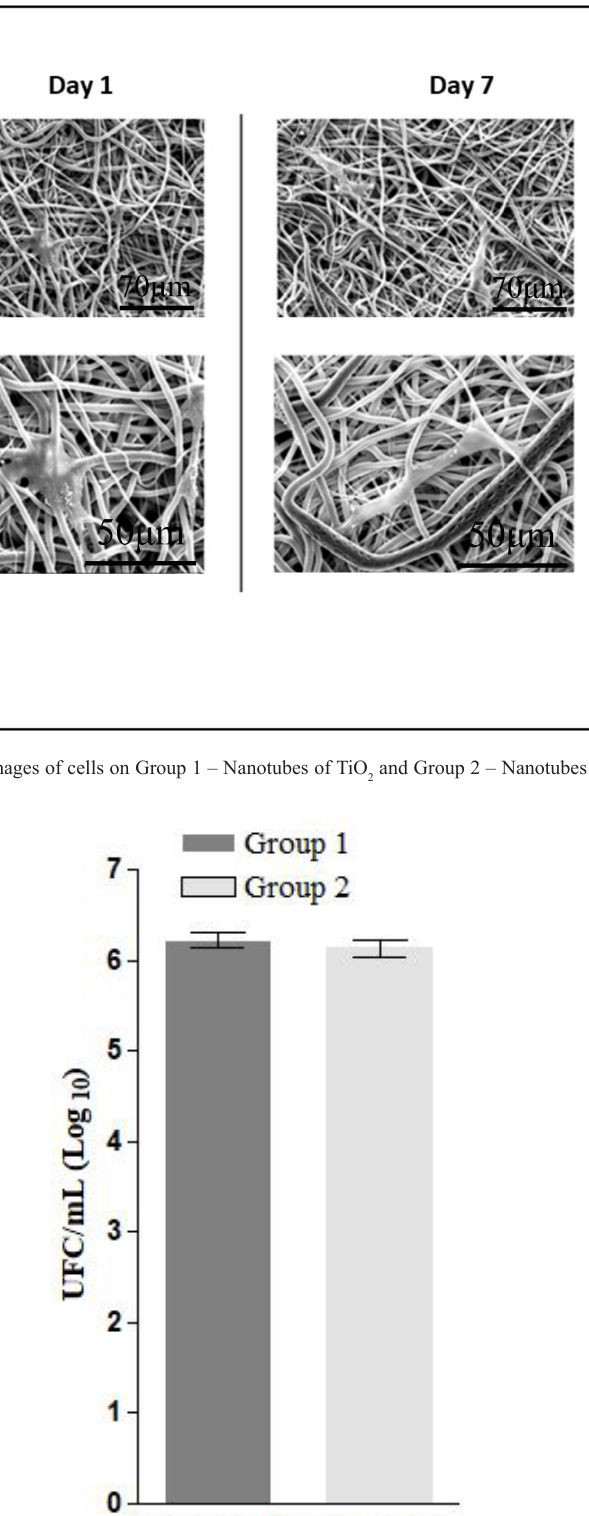
and Group 2 – Nanotubes of TiO 2